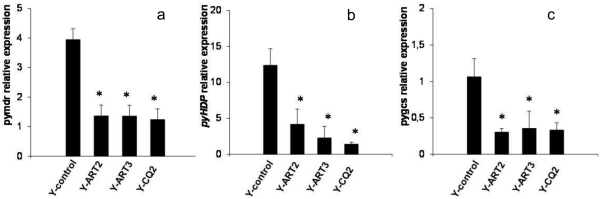
mRNA expression of pymdr (A) pyhdp (B) and pygcs (C).The results show relative expression in arbitrary units normalized to pysts expression (mean ± SEM of 3 independent experiments). *Comparison of Y-ART2, Y-ART3 and Y-CQ2 vs Y-control: p<0.03 by a one-way analysis of variance test and then p<0.05 by a pair-wise multiple comparison test vs Y-control group (Dunnett's method).